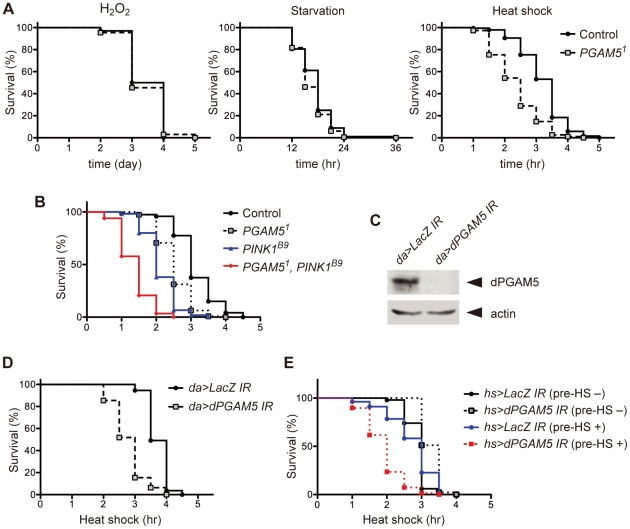
Flies deficient in dPGAM5 are vulnerable to HS.(A) PGAM51 flies are vulnerable to HS. Survival curves of adult male control (y1w1/Y) and PGAM51 flies (y1, PGAM51/Y) subjected to oxidative stress (0.1% H2O2, n = 66; left), starvation (n = 180; middle), or HS (37°C, n = 190; right) are shown. Control vs. PGAM51 in HS, p<0.0001 by the log-rank test. (B) dPGAM5 and dPINK1 act independently in HS response. Survival curves of the indicated adult male flies (day 5–15) subjected to HS are shown (control, n = 120; PGAM51, n = 112; PINK1B9, n = 105; PINK1B9, PGAM51, n = 116). PINK1B9 vs PGAM51, PINK1B9, p<0.0001 by the log-rank test. The genotypes are revertant PINK1REV/Y (Control), PGAM51/Y (PGAM51), PINK1B9/Y (PINK1B9) and PGAM51, PINK1B9/Y (PGAM51, PINK1B9). (C) Efficiency of IR-mediated dPGAM5 knockdown. Protein expression of dPGAM5 in daughterless (da)>LacZ IR flies (da-GAL4/+; UAS-LacZ IR/+) and da>dPGAM5 IR flies (da-GAL4/+; UAS-dPGAM5 IR/+) was detected by immunoblotting with dPGAM5 antibody. Actin was also detected as a loading control. (D) Knockdown of dPGAM5 in the whole body induces vulnerability of flies to HS. Survival curves of adult male da>LacZ IR flies and da>dPGAM5 IR flies subjected to HS are shown (n = 110). p<0.0001 by the log-rank test. (E) Transient knockdown of dPGAM5 prior to HS is sufficient to induce vulnerability of flies to HS. Survival curves of the indicated adult male flies subjected to HS are shown. IR RNA was induced two days prior to sustained HS by two cycles of HS pretreatment, each of which was composed of 37°C for 30 min, 25°C for 5 hr, 37°C for 30 min and 25°C for 18 hr. “Pre-HS +” and “pre-HS −” indicate flies expressing and not expressing IR RNA, respectively, when they were subjected to sustained HS. The genotypes are hs-GAL4/UAS-LacZ-IR (hs>LacZ-IR) and hs-GAL4/UAS-dPGAM5-IR (hs>dPGAM5-IR). hs>LacZ-IR (pre-HS +) flies (n = 79), hs>dPGAM5-IR (pre-HS +) flies (n = 68), hs>LacZ-IR (pre-HS −) flies (n = 50) and hs>dPGAM5-IR (pre-HS −) flies (n = 45) were examined. hs>LacZ-IR (pre-HS +) vs hs>dPGAM5-IR (pre-HS +), p<0.0001 by the log-rank test.